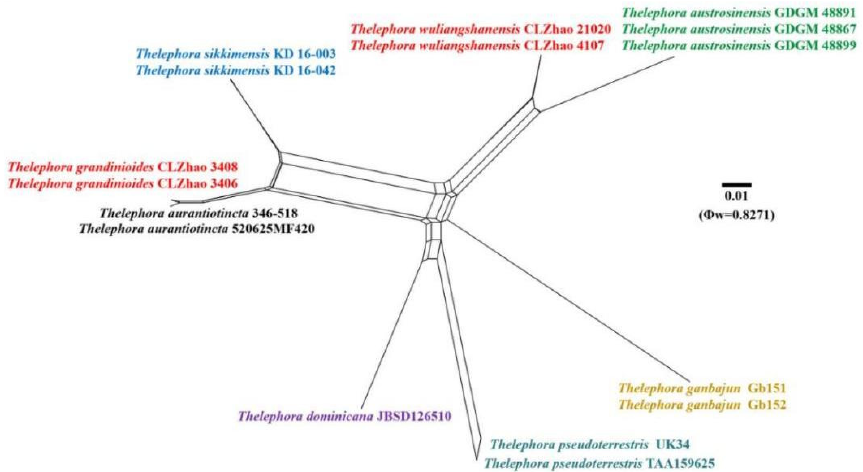
Figure 5. Split graphs showing the results of PHI test for the ITS data of Thelephora grandinioides and T. wuliangshanensis and closely related taxa using LogDet transformation and splits decomposition. PHI test results Φ w ≤ 0.05 indicate that there is significant recombination within the dataset. New taxa are in red while, closly related species to new species are in other